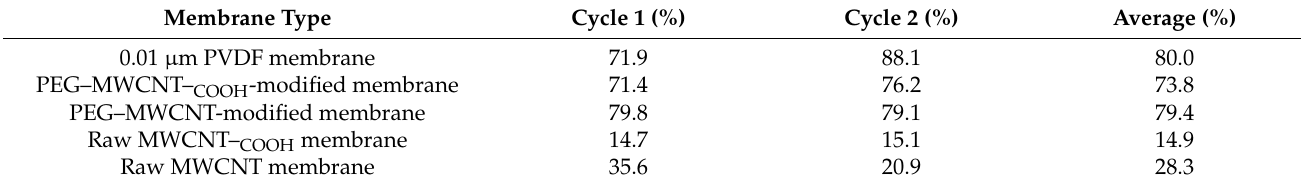
Figure 11. ( a ) TMP growth (P − P 0 ) in the constant flux filtration of BSA. ( b ) TMP growth of the four MWCNT membranes in BSA constant flux filtration. The concentration of BSA solution was 200 mg · L − 1 and the flux was stabilized at 75 L · h − 1 · m − 2 . After constant flux filtration of BSA solution for 85 min, cross flow flushing was carried out for 6 min, and each membrane was operated for three cycles. Table 3. The TMP recovery rate after cross flow